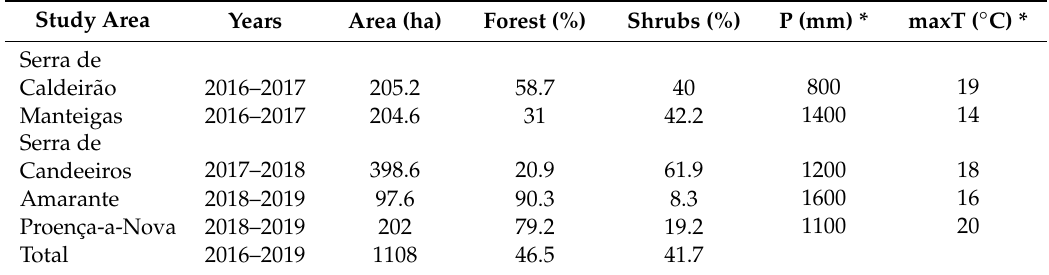
Table 2. Study sites studied years, fuel break area, land cover composition and climate conditions. Study Area Years Area (ha) Forest (%) Shrubs (%) P (mm) * maxT ( ◦ C)